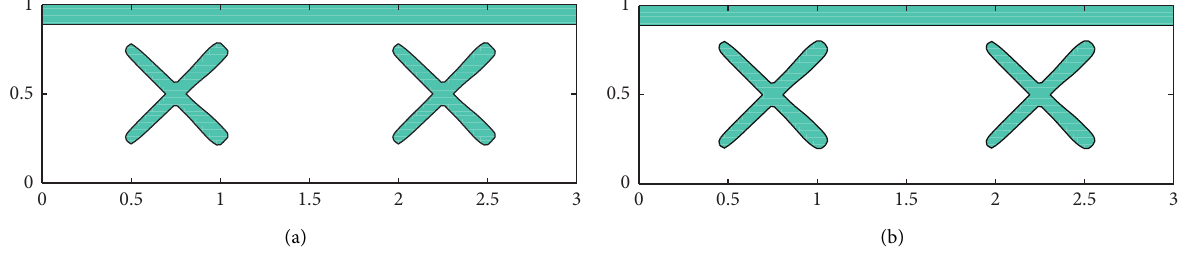
Figure 18: The initial designs for the bridge problem: (a) the QVT method and (b) the paper method.